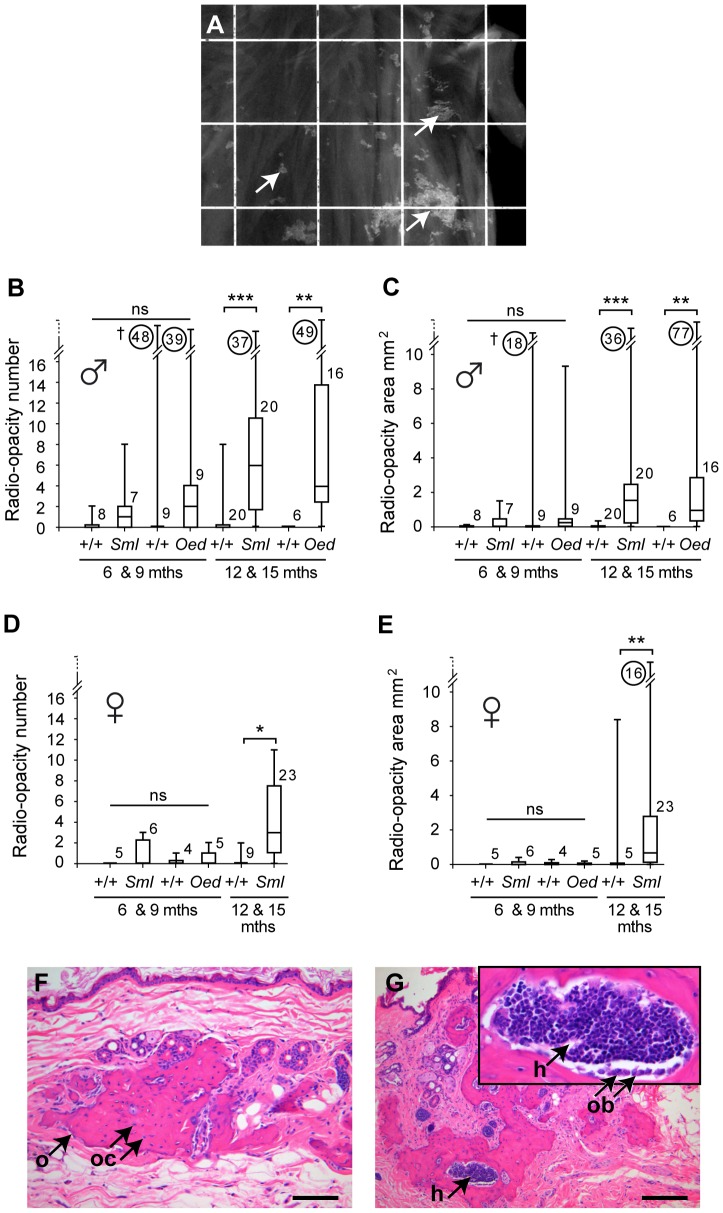
Skin radio-opacities increase with age in Sml and Oed mice and correspond to foci of osseous heteroplasia.(A) X-ray image of radio-opacities in the skin of a 12-month-old Sml male imaged on a 1×1 cm grid. (B) The number and (C) cumulative area of skin radio-opacities in Sml and Oed male mice at 6 & 9 months of age are not significantly different from +/+ controls, however they are significantly increased in the 12 & 15-month-old cohorts compared to +/+ mice. (D) The number and (E) cumulative area of skin radio-opacities in Sml and Oed females at 6 & 9 months of age are not significantly different from +/+ controls, however they are significantly increased in the 12 & 15-month-old Sml compared to +/+ controls. In the box and whisker plots each box represents the median with 25 and 75% inter-quartile ranges, with whiskers representing the data range (minimum and maximum). The group size n is indicated alongside each histogram bar, whereas the circled numbers are the off-scale maximum values. ns = not significant P>0.05, * P<0.05, **P<0.01, ***P<0.001. Kruskall Wallis non-parametric one-way ANOVA tests were performed with Dunn's multiple comparison tests for post hoc testing. † A single male +/+ control with high levels of radio-opacities was an outlier that had a wounded skin. (F). Radio-opacities correspond to foci of osseous heteroplasia (arrow o) with osteoclasts (arrow oc) beneath intact skin. (G) Focus of hematopoietic tissue (arrow h) within an area of osseous heteroplasia, inset is enlarged view (arrow h), the bone surface has an osteoblast layer (arrow ob). Scale bars: F = 100 µm; G = 200 µm.